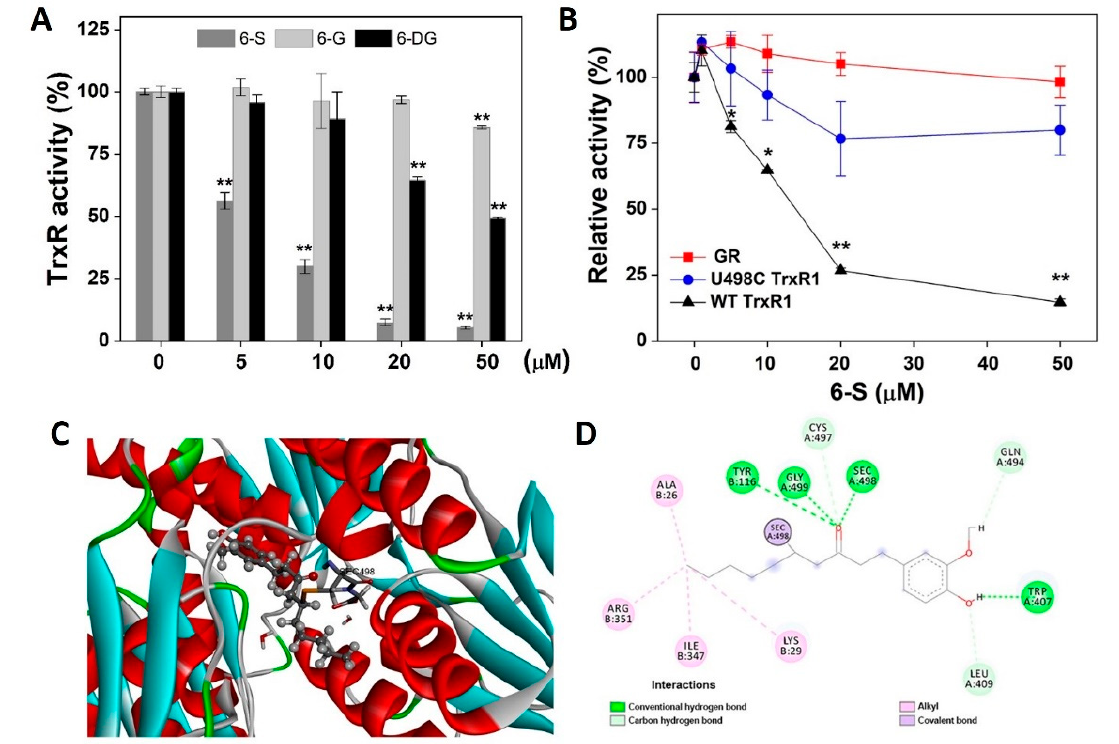
Figure 2. Inhibition of TrxR activity by 6-S. ( A ) Dose-dependent inhibition of TrxR by 6-S, 6-G, and 6-DG. The activity of TrxR was determined using the endpoint insulin reduction assay. ( B ) Inhibi- tion of WT TrxR, U498C TrxR, and GR by 6-S. WT TrxR1, U498C TrxR1, and GR were incubated with the indicated concentrations of 6-S for 2 h at room temperature, and the enzyme activities were determined. ( C ) The surface representation of the reactive site of 6-S on rat TrxR1. ( D ) Covalent binding mode of the rat TrxR1 and 6-S. Data are expressed as the mean ± standard error from three experiments. *, p < 0.05, and **, p < 0.01 vs. the control group.